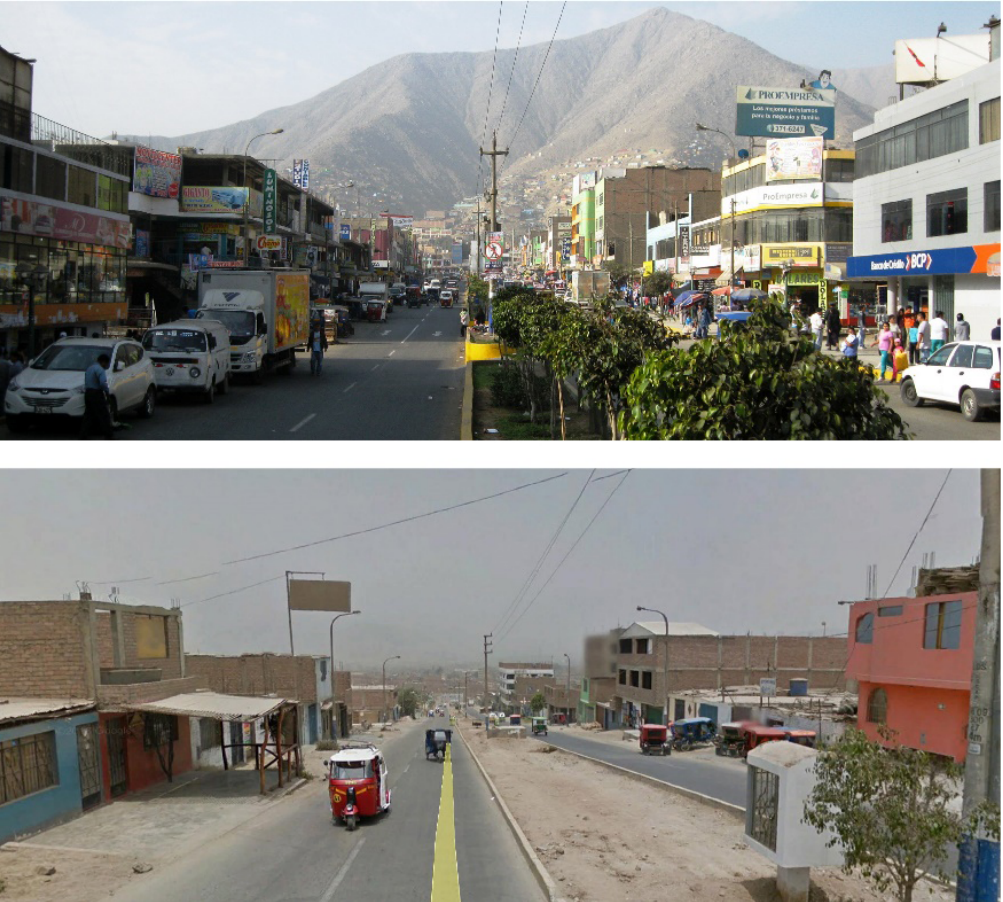
Figure 9. Comparison between central areas in Huaycán (top) and Horacio Zevallos (bottom). Source: Authors and Google Street View (in